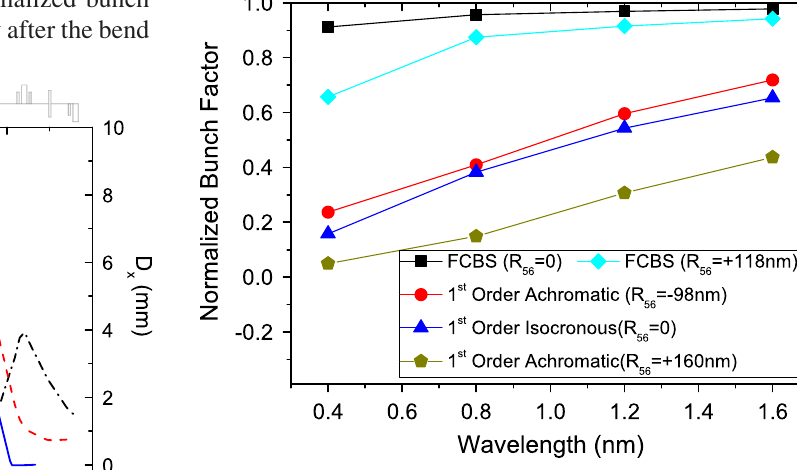
FIG. 14. (Color) Changes of the normalized bunch factor with respect to its initial value directly after the bend as a function of the radiation wavelength for the different kinds of bending systems treated in this paper.